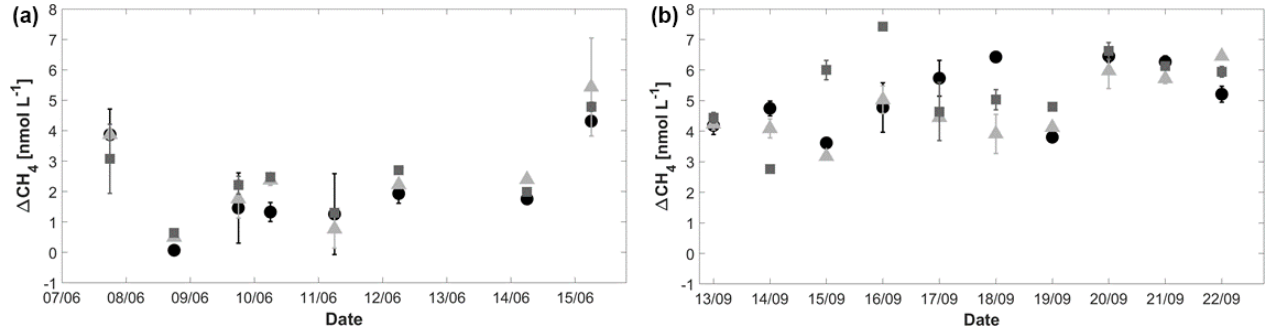
Figure 6. (cid:49) CH 4 in June (a) and September (b) for surface water at 0.1m depth (dots), 0.5m depth (triangles), and 1m depth (squares). Error bars were calculated as described in the Methods section.